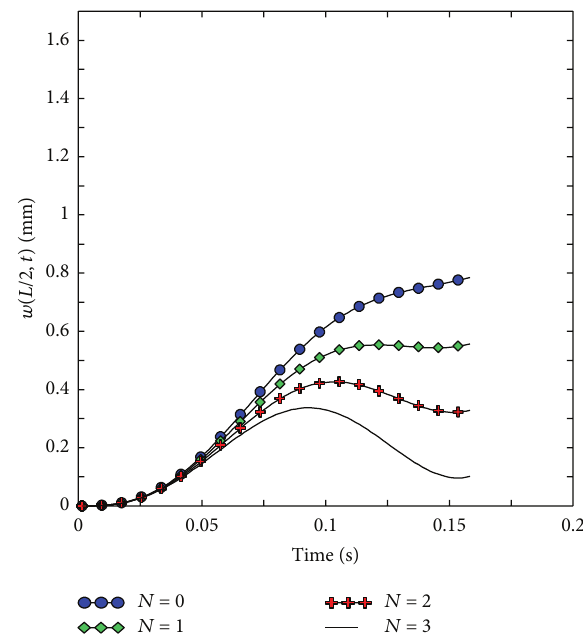
Figure 13: The dynamic response ( 𝑤(𝐿/2, 𝑡) ) for the beam with 𝜁 = 0.15 , subjected to a moving vehicle attached to many